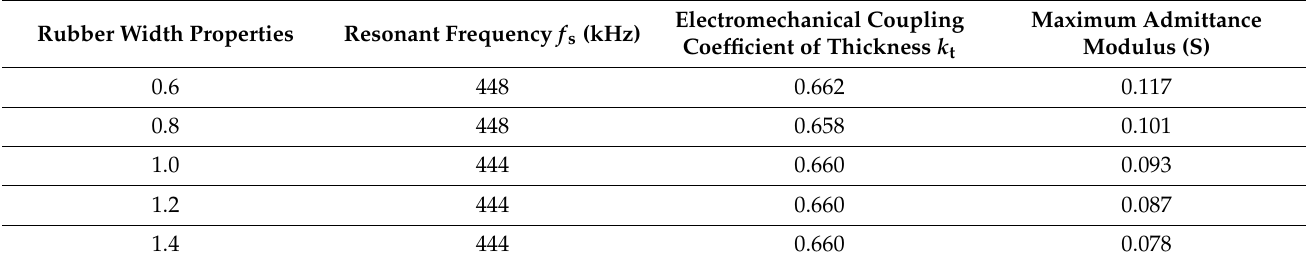
Table 3. The effect of transverse polymer width on material